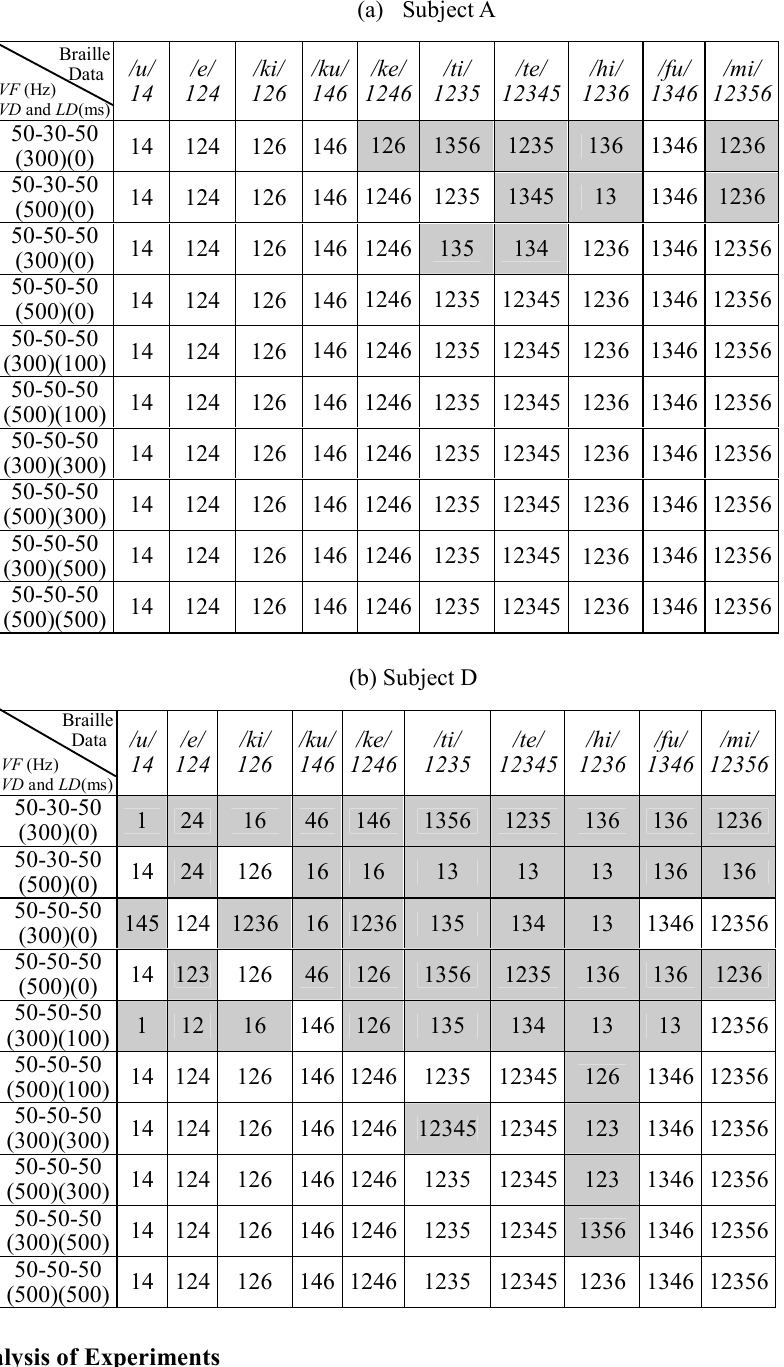
Table 6 Recognition Results of Each Character by two Subjects A and